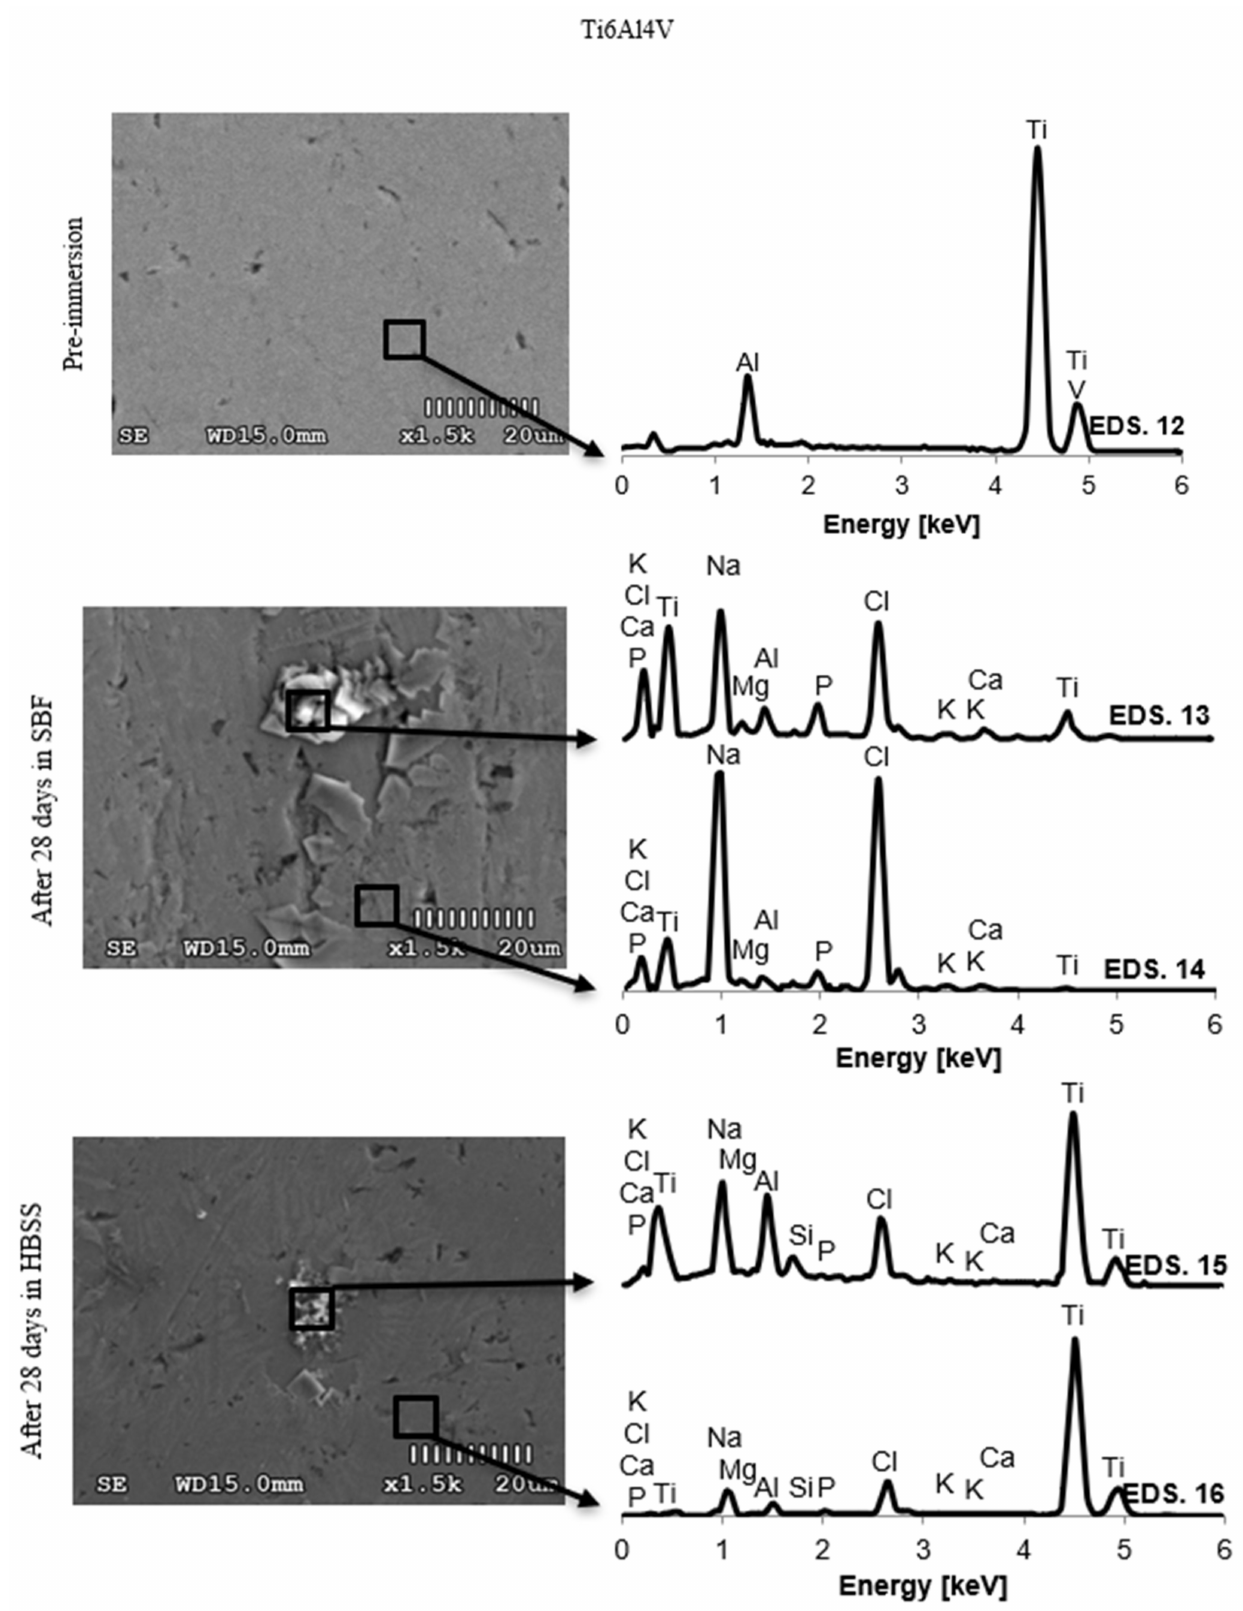
Figure 7. Spectrum EDS of Ti6Al4V before and after 28 days of material samples immersion in SBF and